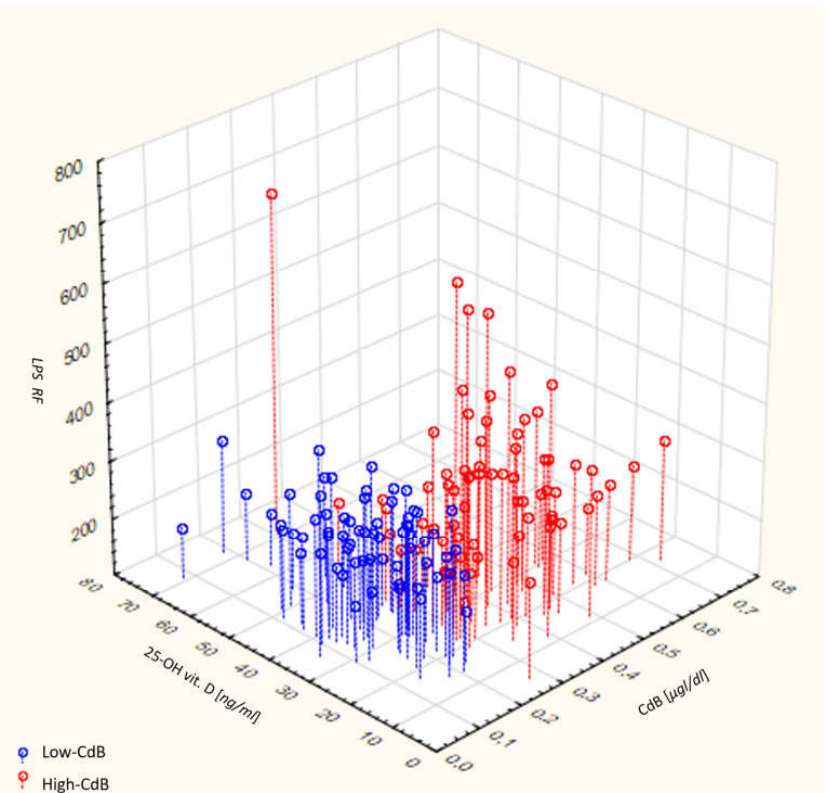
Figure 2. A three-dimensional PCA plot generated from principal component analysis (PCA) of the quantitative variables related to blood cadmium concentrations [µg/dL], concentration of lipofuscin (LPS), and 25-OH vitamin D concentration [ng/mL]. The blue dots indicate the data points corre- sponding to the Low-CdB (Cd level below median) subgroup, whereas the red dots correspond to the High-CdB (Cd value above median) subgroup.